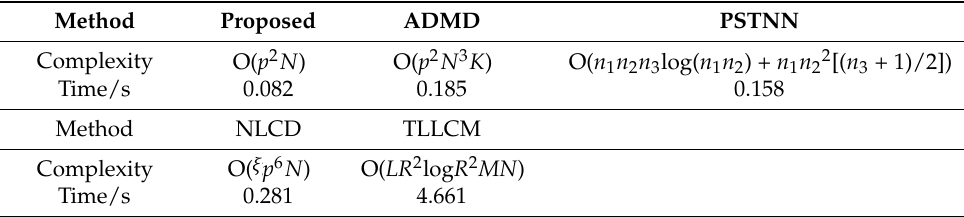
Table 3. The complexity and time consumption of typical methods.